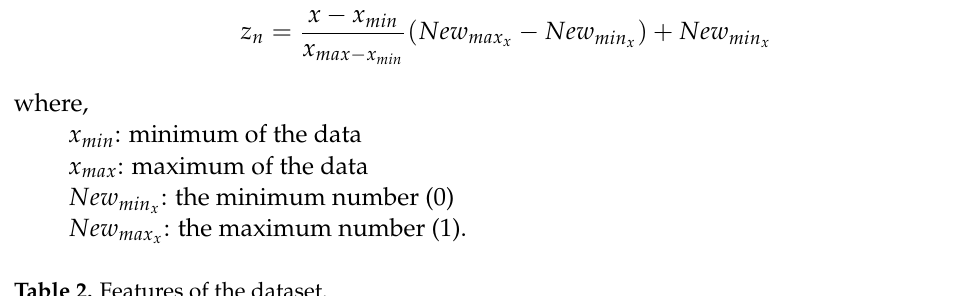
Table 2. Features of the